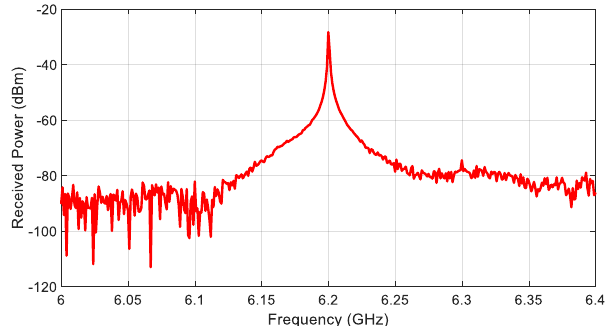
Table 1. Various nonlinear targets and their estimated nonlinear RCS based on the received power [30]. Nonlinear Target (Size, 2 c m )